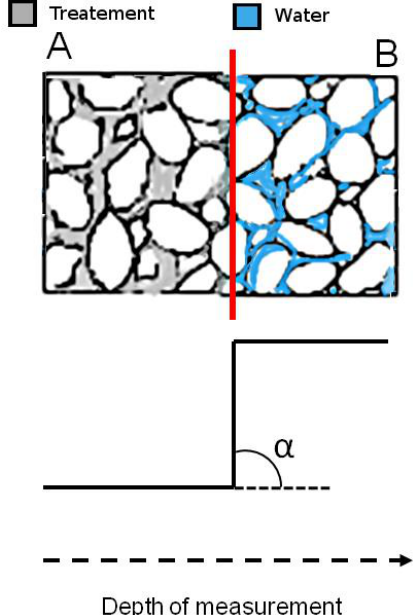
Figure 9. Top, sketch of an inhomogeneous region in a treated stone. Bottom, 1 H depth profile encoding the inhomogeneous